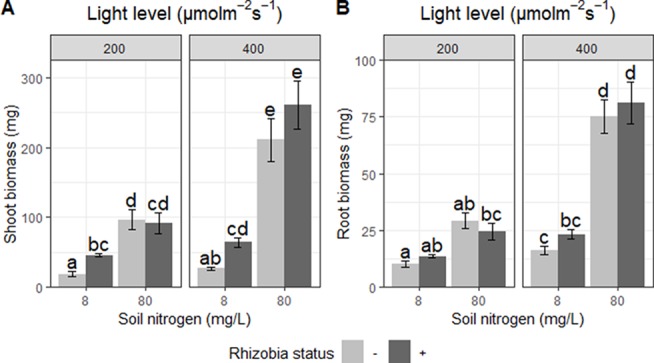
Effects of light, nitrogen, and rhizobia on shoot and root biomass. (A) Shoot biomass and (B) root biomass of Medicago truncatula plants in response to changing soil nitrogen, light availability, and the presence or absence of rhizobia. Error bars represent +/− one standard error (8–11 replicates). Note that root and shoot biomass were ln-transformed to improve normality in the ANOVA but are represented here without transformation for ease of interpretation. Bars with the same letter within an individual panel do not significantly differ after post hoc testing with the Tukey test (P > 0.05).